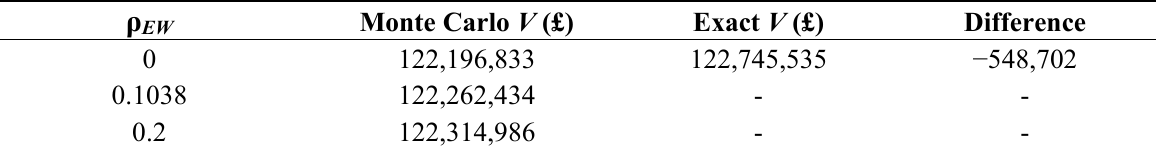
Table 9. Present value under the electricity price.